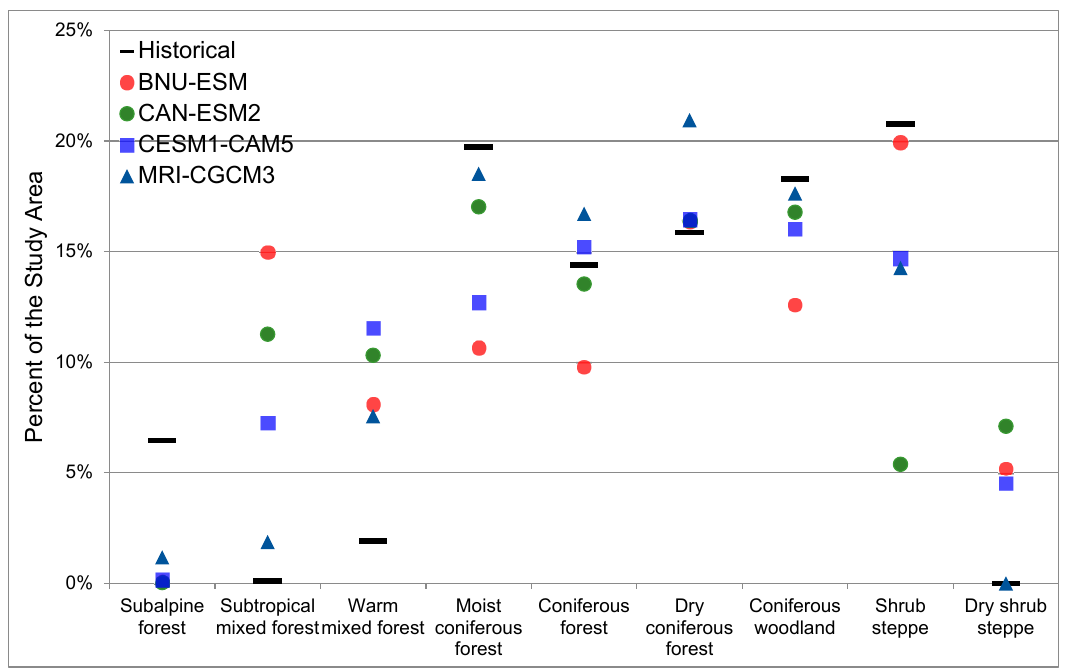
Figure 5. Percent of the study area that individual vegetation types cover for historical and four future projections for ( a ) midcentury (2035–2064) and ( b ) end of the century (2070–2099) under RCP 8.5.